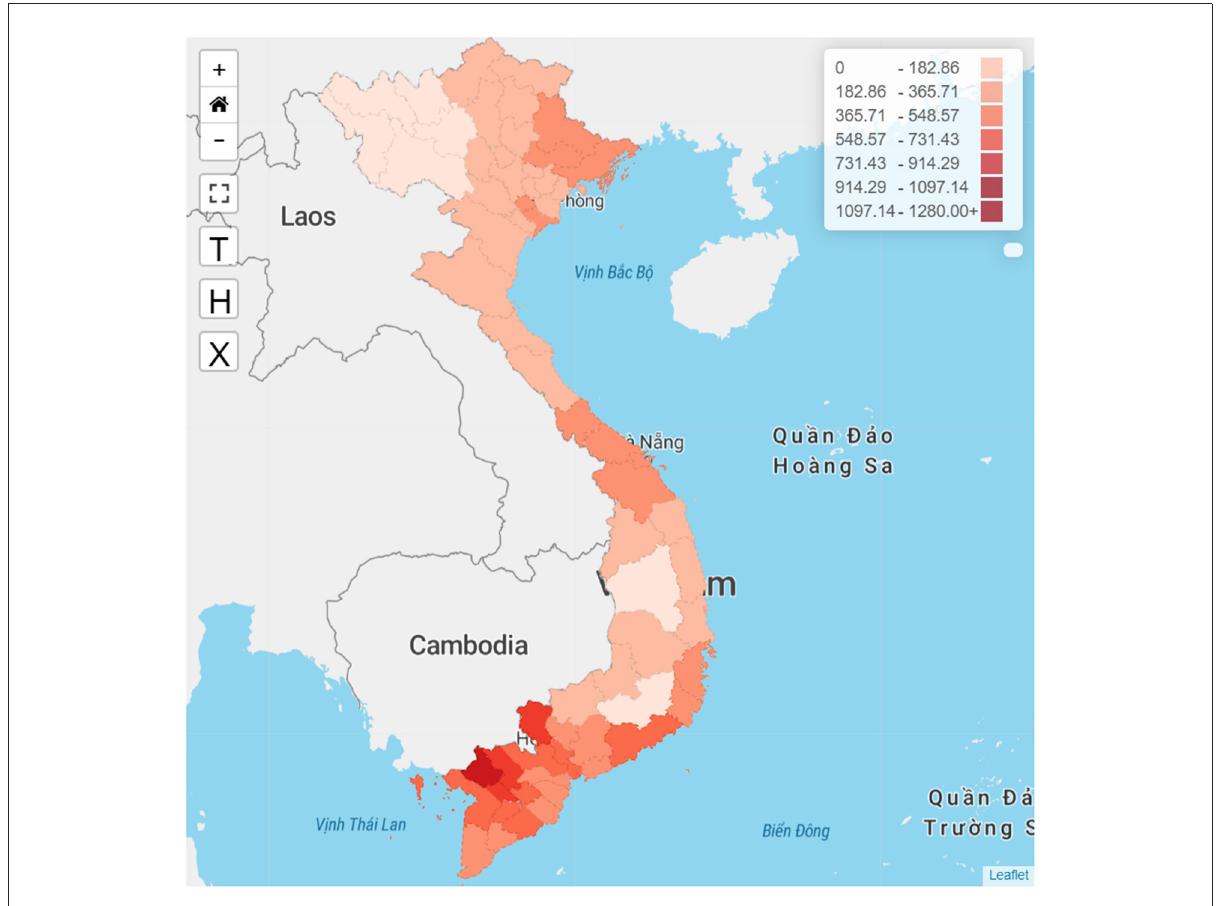
FIGURE1 Home screen of the GeoAI